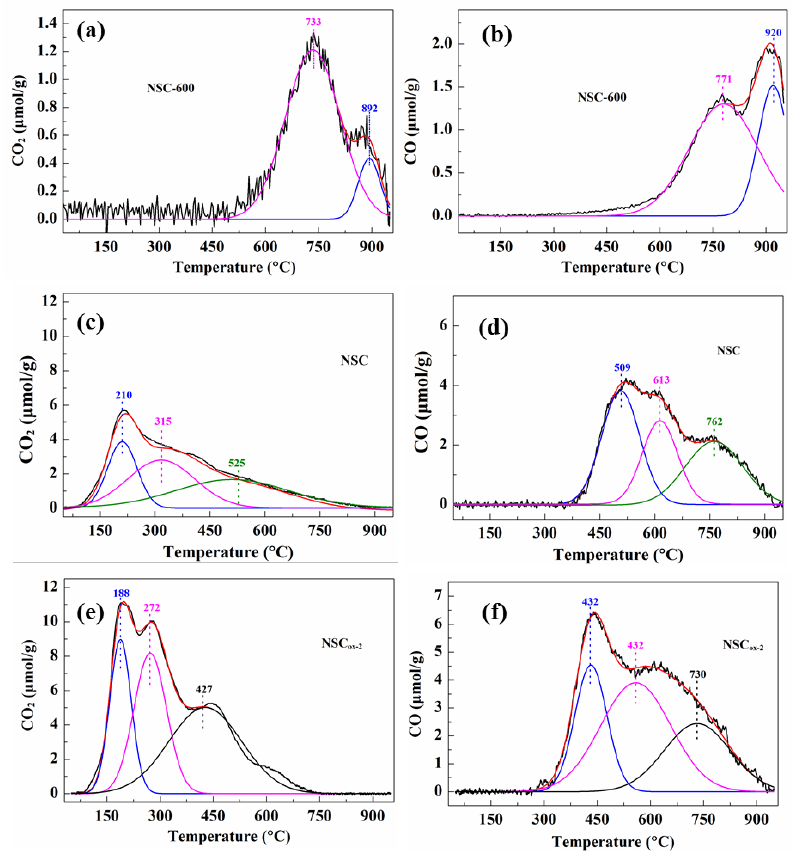
Figure 5. Results of deconvolutions on CO 2 -TPD and CO-TPD profiles using a multiple Gaussian function; ( a ) CO 2 -TPD profile of NSC-600, ( b ) CO-TPD profile of NSC-600, ( c ) CO 2 -TPD profile of Table 2. Results of the deconvolution of CO 2 -TPD spectra using a multiple Gaussian function.